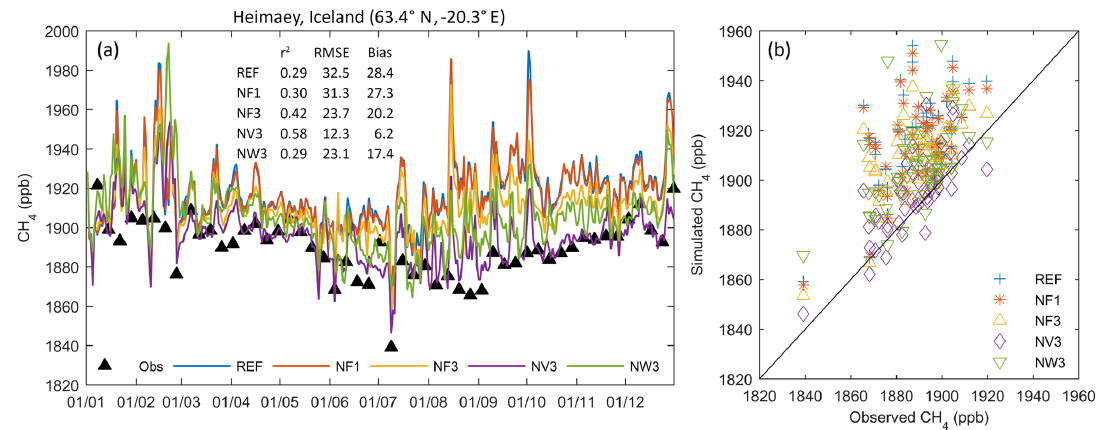
Figure 7. Methane (ppb) as observed and modelled in Heimaey in 2013 for a selection of FLEXPART CTM simulations, shown as time series (a) and a scatter plot (b)